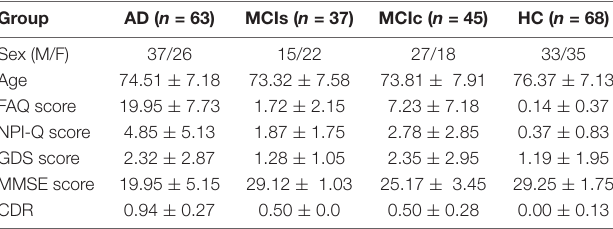
TABLE 1 | Neuropsychological and demographic characteristics of participants.